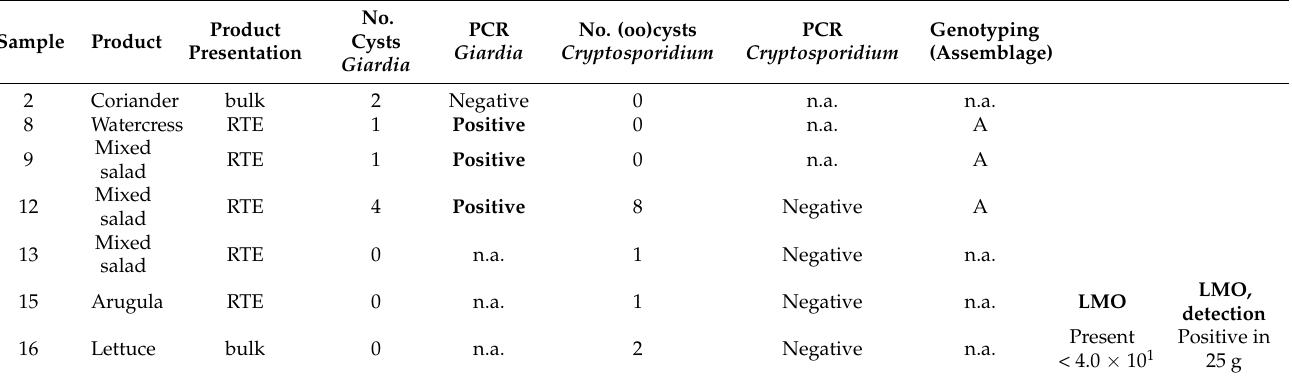
Figure 1. Epifluorescence microscopy images (400 × magnification) of Giardia cysts ( A ) and Cryp- tosporidium oocysts ( B ) found in sample 12. Table 2. Protozoa and bacteria positive